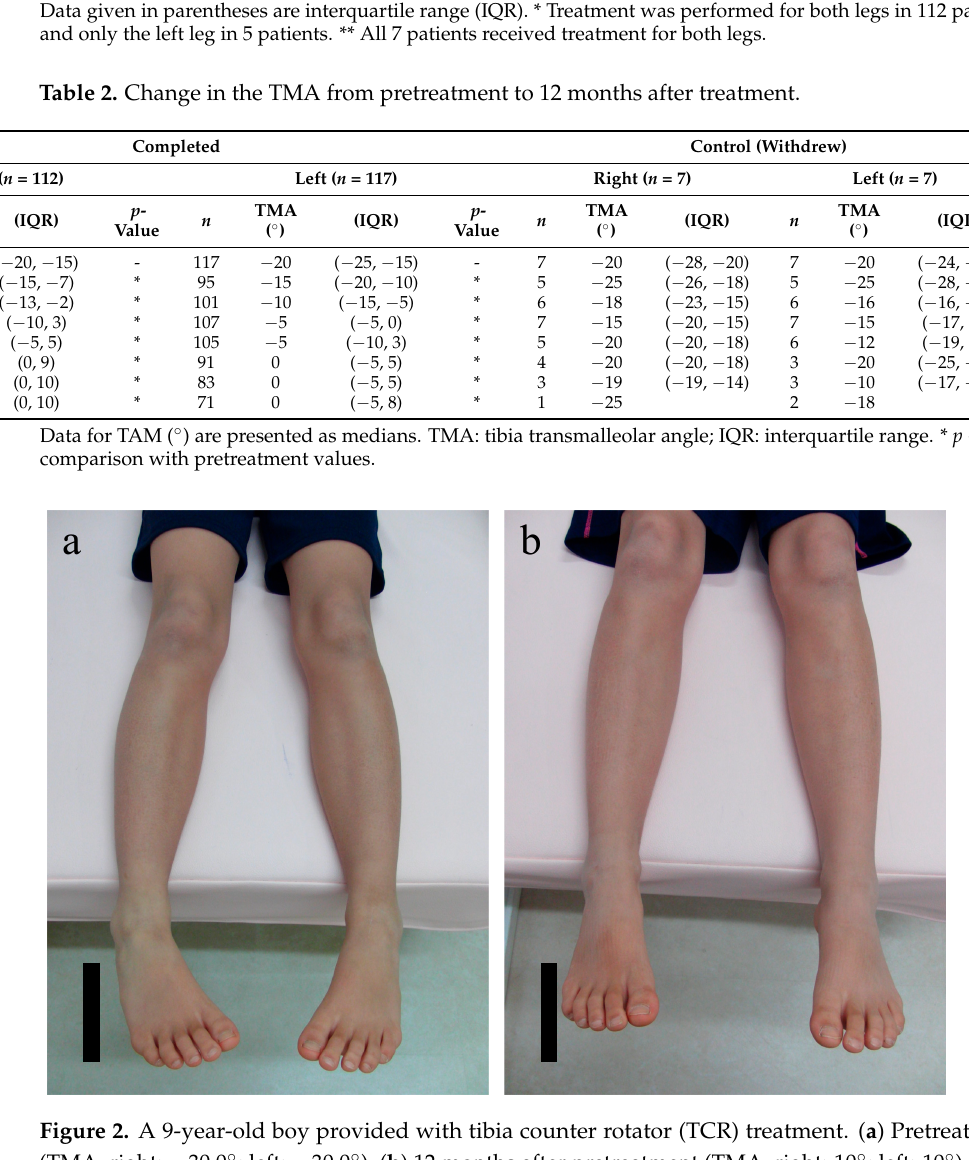
Table 2. Change in the TMA from pretreatment to 12 months after treatment.